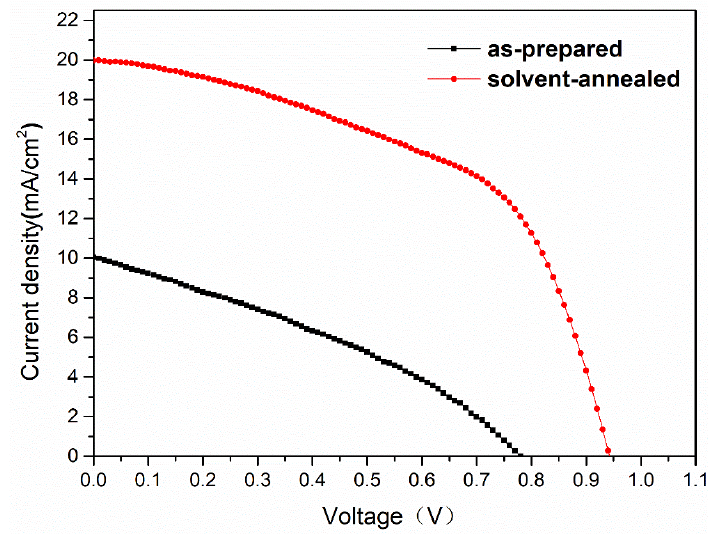
Table 2. The performance of the as-prepared and solvent-annealed MAPbI 3 solar cells.